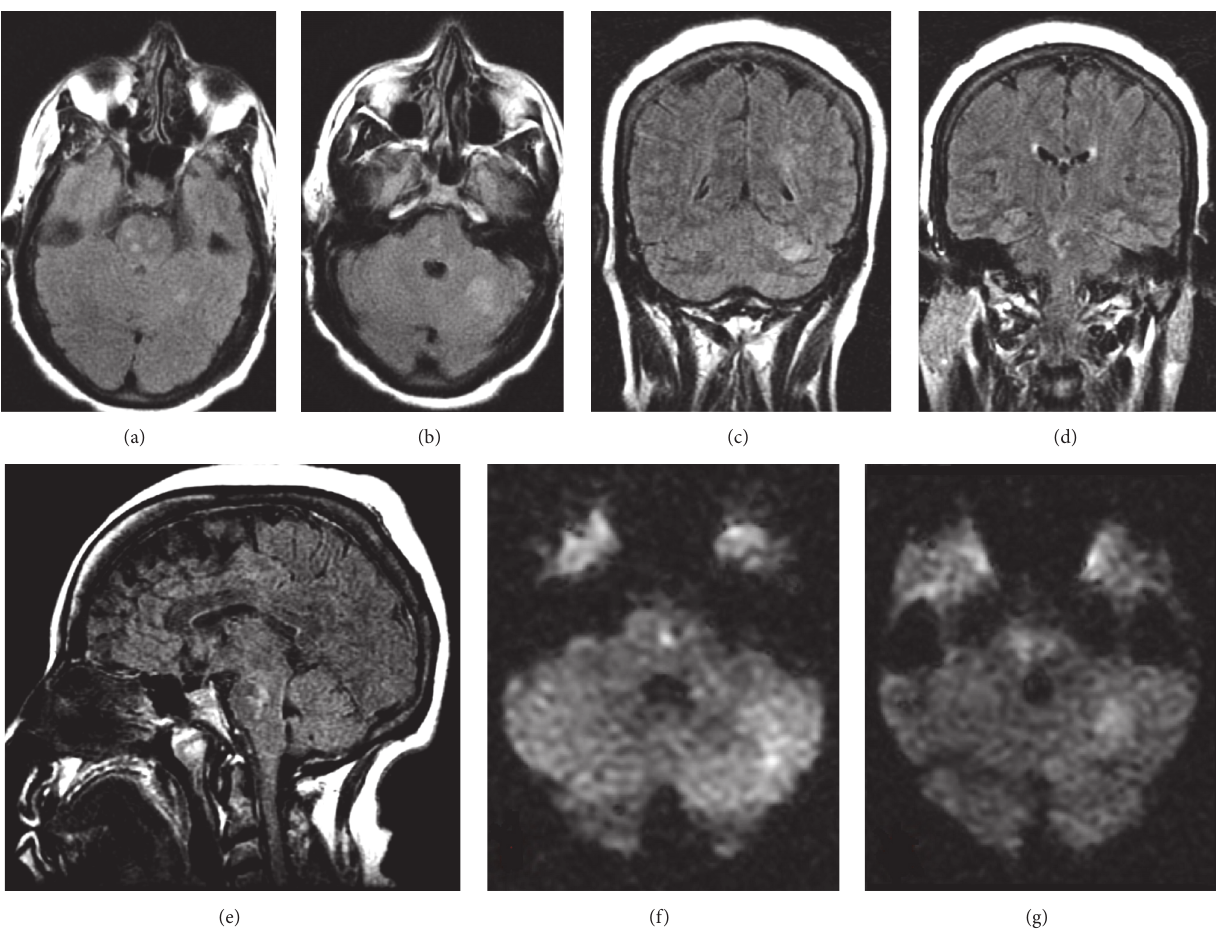
Figure 2: Brain MRI. (a, b, c) Abnormal FLAIR signal involving the left cerebellum. (a, b, d, e) Abnormal FLAIR signal involving several small foci within the pons. (f and g) Diffusion weighted imaging sequence consistent with multiple regions of acute ischemia in the pons and left